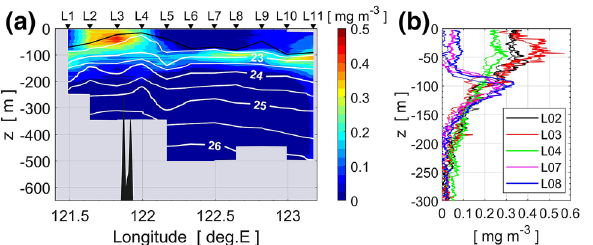
Figure 8. ( a ) Vertical section of chlorophyll a obtained by the TurboMAP profiler from L1 to L10 and at L11 by SBE-9plus on 25–26 November. Contour lines show isopycnals and the thick solid line represents the surface mixed layer depth. ( b ) Vertical profiles of chlorophyll at L2, L3, L4, L7, and L8, where thick and thin lines show profiles obtained with the two casts at each